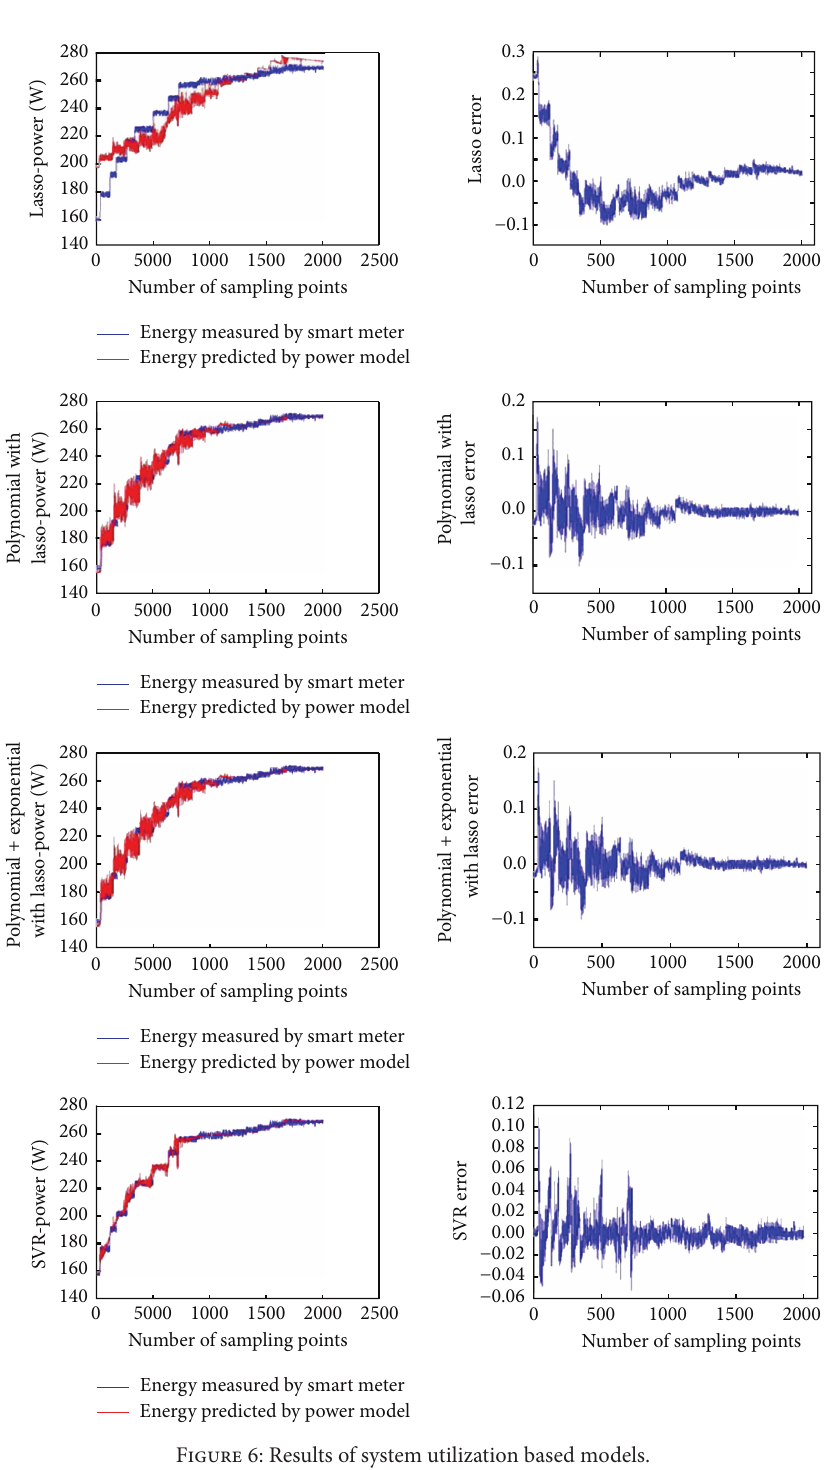
Figure 6: Results of system utilization based